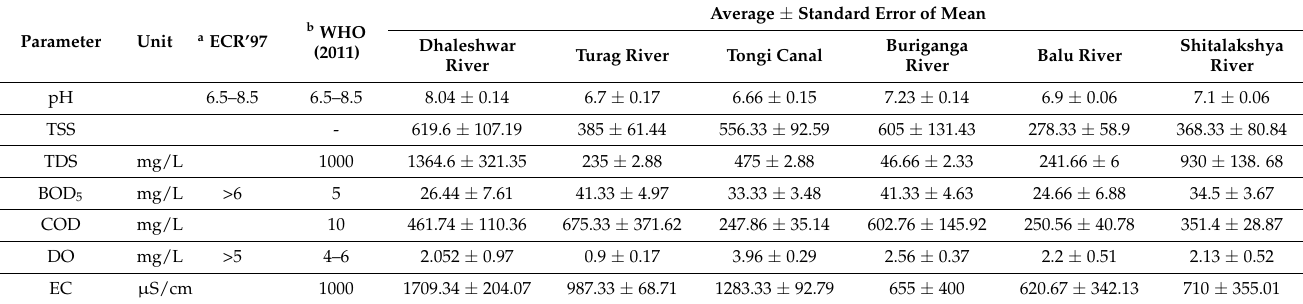
Table 3. Results of Physicochemical properties of the peripheral rivers around Dhaka